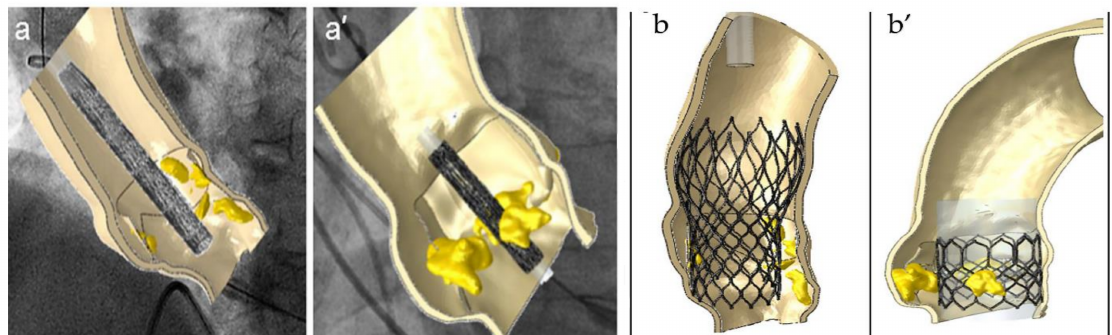
Figure 7. FEA simulations of TAVI in two investigated patients who showed post-operative throm- bosis. The positioning ( a , a (cid:48) ) and reopening ( b , b (cid:48) ) of CoreValve and SAPIEN devices (left and right sides, respectively). Abbreviations in other